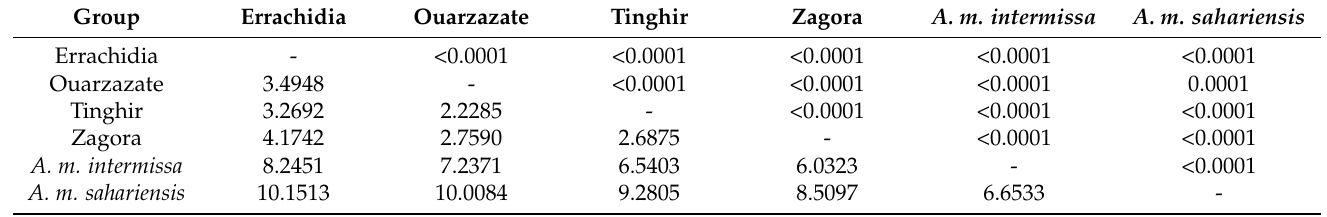
Figure 2. Variation of wing shape of honey bees in four areas of south-eastern Morocco in compar- ison to reference samples of A. m. sahariensis and A. m. intermissa illustrated with the first two prin- cipal components ( A ) and first two canonical variates ( B ). Each marker represents the mean scores of each colony. The ellipses represent 95% confidence intervals around the centroid of each data cluster. Table 1. Mahalanobis distances (lower triangle) and significance of pair-wise statistical differences (upper triangle) in wing shape of honey bees from four areas of south-eastern Morocco and reference samples of A. m. sahariensis and A. m. intermissa .